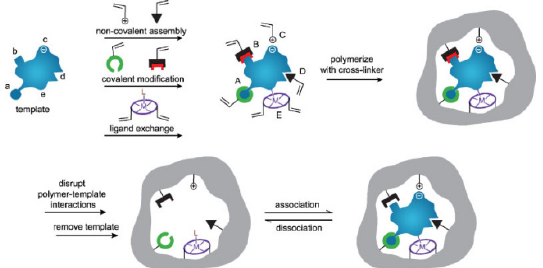
Figure 1. Highly schematic representation of the molecular imprinting process. The formation of reversible interactions between the template and polymerizable functionality may involve one or more of the following interactions: [( A ) reversible covalent bond(s), ( B ) covalently attached polymerizable binding groups that are activated for non-covalent interactions via template cleavage, ( C ) electrostatic interactions, ( D ) hydrophobic or van der Waals interactions or ( E ) co-ordination with a metal center, each formed with complementary functional groups or structural elements of the template, ( a – e ) respectively]. Subsequent polymerization in the presence of crosslinker(s), a cross-linking reaction or other process results in the formation of an insoluble matrix (which itself can contribute to recognition through steric, van der Waals and even electrostatic interactions) in which the template sites reside. The template is then removed from the polymer through the disruption of polymer—template interactions and extraction from the matrix. The template, or analogues thereof, may then be selectively bound again by the polymer in the sites vacated by the template, the ‘imprints’. While the representation here is specific to vinyl polymerization, the same basic scheme can equally be applied to sol-gel, polycondensation, etc. [16].